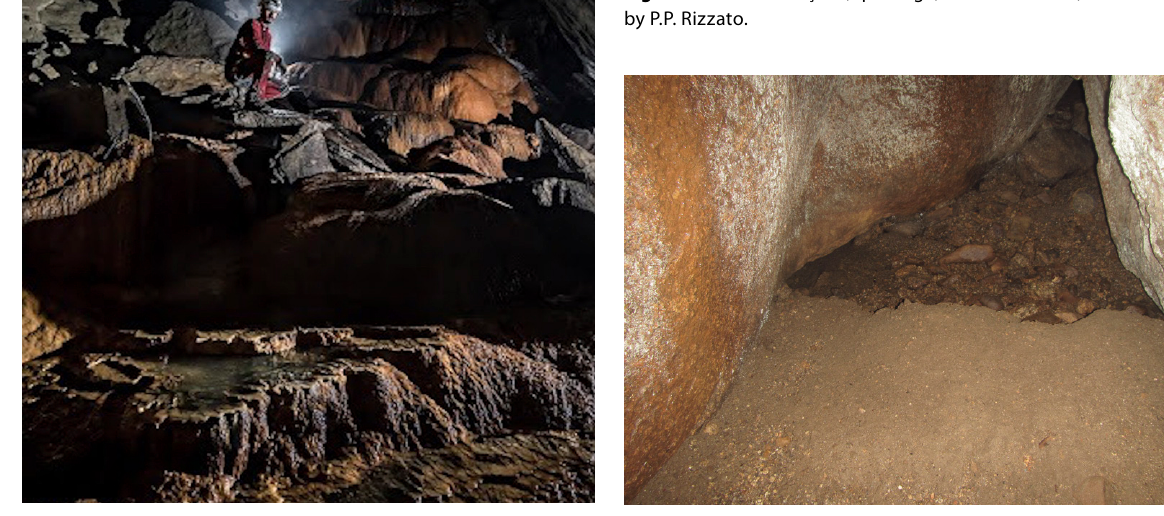
Figure 10. Gruta do Saco Grande, Florianópolis, Santa Catarina state, Brazil. Photo by J.E. Gallão.